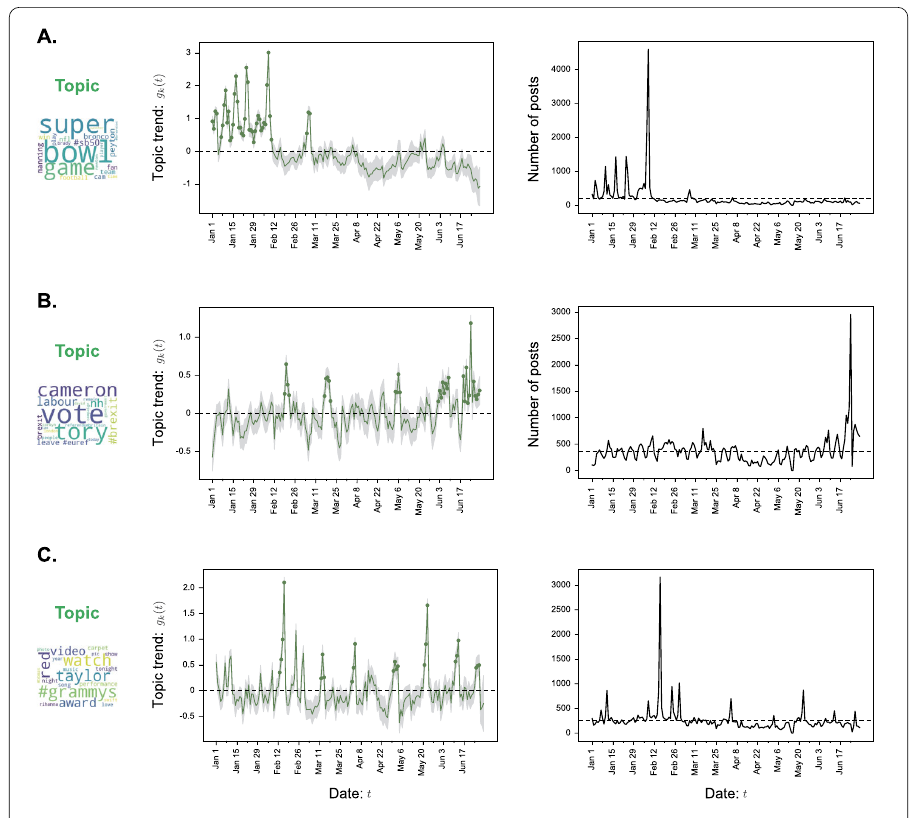
Figure 6 A comparison between the topic trend g k ( t ) (green in the left panels) and the popularity of posts (black in the right panels) over time in Twitter. The gray area represents the 95% confidence interval of the topic trend. Filled circles mark the days when the topic trend is significantly higher than zero for at least three consecutive days. The three examples are the same as those in Fig. 3